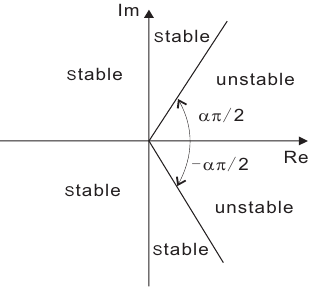
Figure 1. Stable region of linear fractional-order system